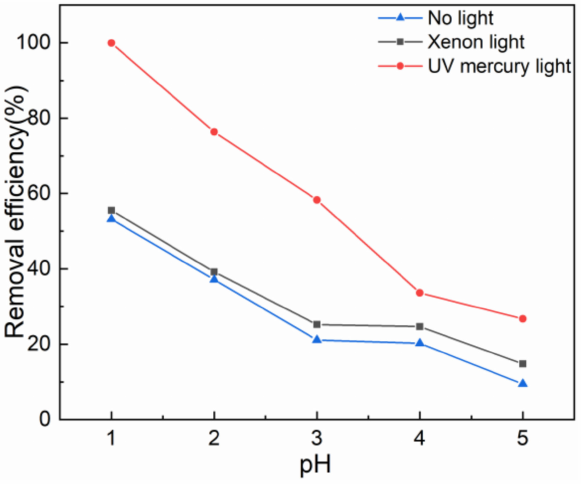
Figure 2. The removal efficiency of Cr(VI) by T-BSA under different light